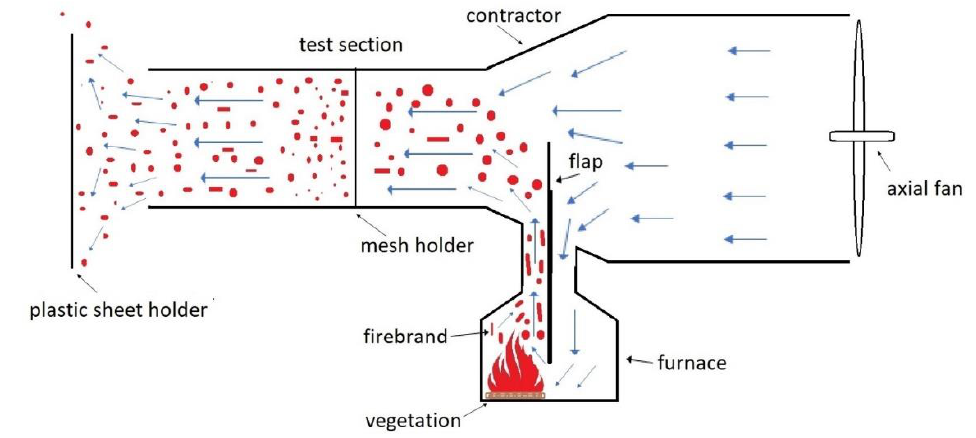
Figure 1. Schematic of the ESS.